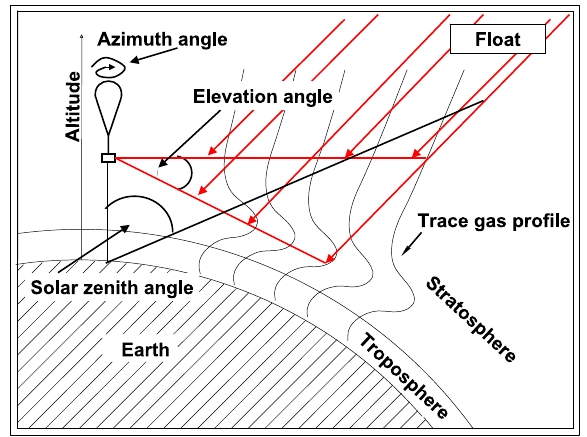
Fig. 1. Observation geometry of balloon-borne limb scattered skylight measurements.